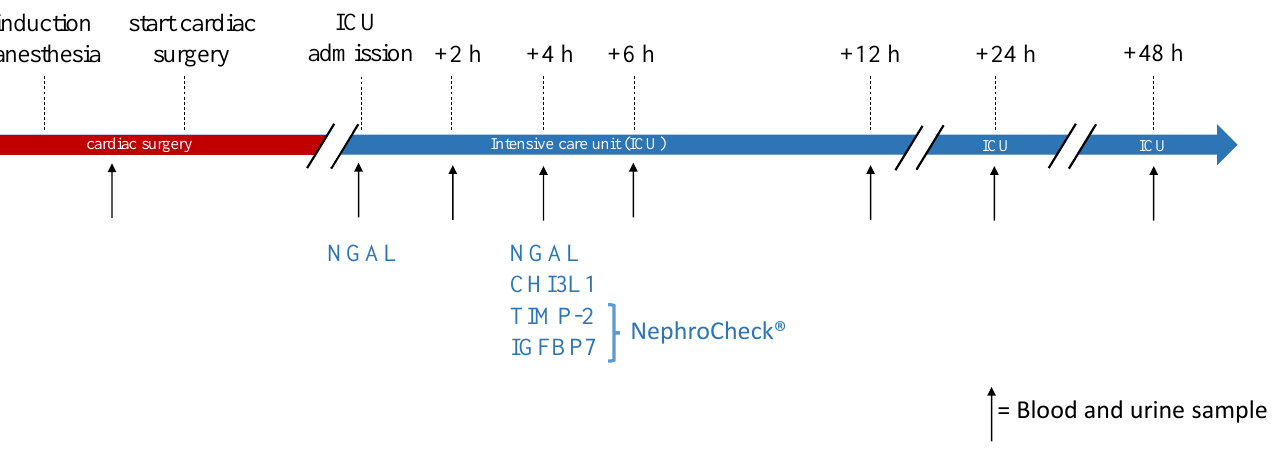
Figure 2. Trail workflow: timing of blood and urine sampling. ICU: intensive care unit; NGAL: neutrophil gelatinase-associated lipocalin; TIMP-2: tissue inhibitor of metalloproteinases-2; IGFBP7: insulin-like growth factor-binding protein